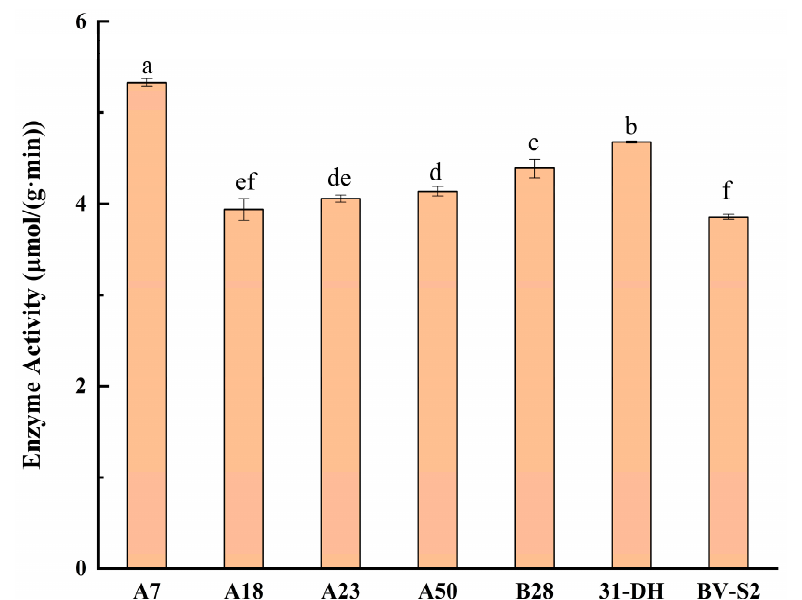
Figure 7. β -D-glucosidase activity of A7, A18, A23, A50, B28, and control strains. Different small letters indicate significant differences according to the LSD Fisher test ( p <